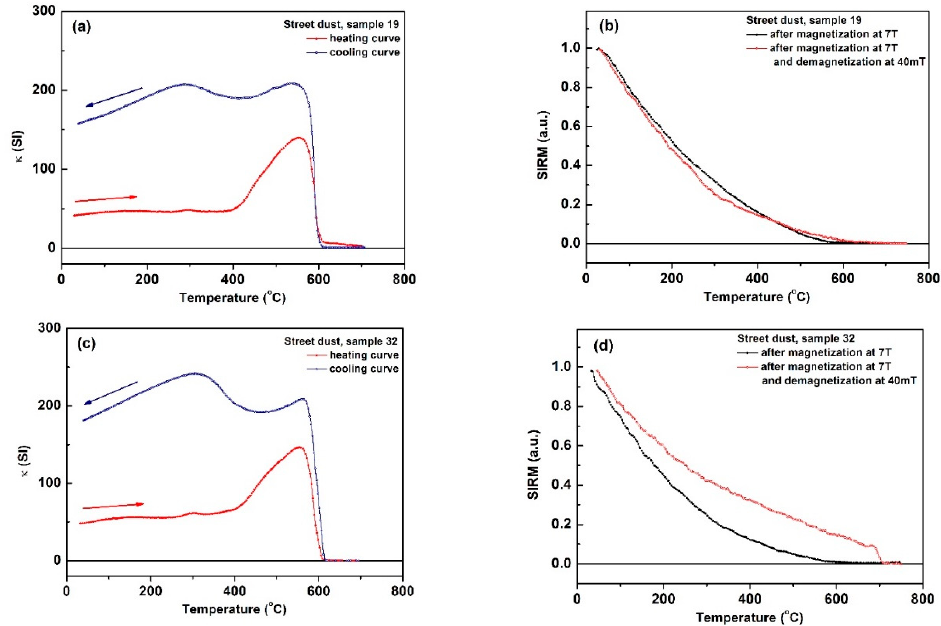
(Supplementary Table S1, Supplementary Figure S2) [31]. The second group, consisting of seven